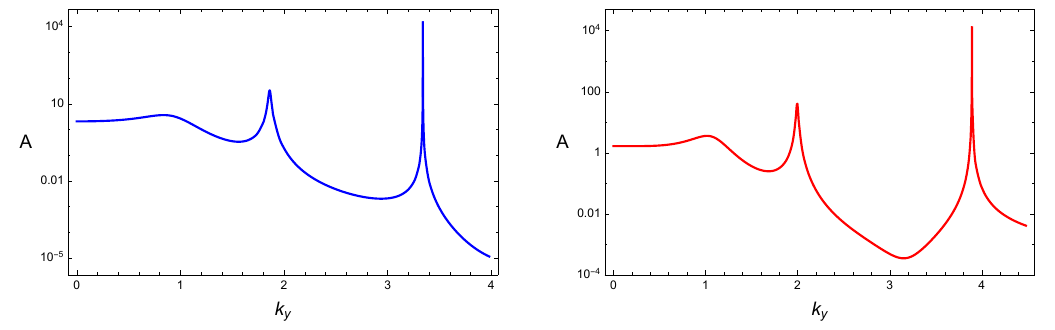
Figure 15 . The MDF along the k y -axis for the amplitude of the ionic lattice a 0 = 0 : 1(left plot) and a 0 = 0 : 8 (right plot) for (cid:12)xed ! = 10 (cid:0) 6 , q = 2 and T = 0 : 019. Note that the vertical axis is logarithmic, and that there is a very sharp peak indicative of a Fermi surface. We have chosen L = 1 and (cid:22) = 2 :